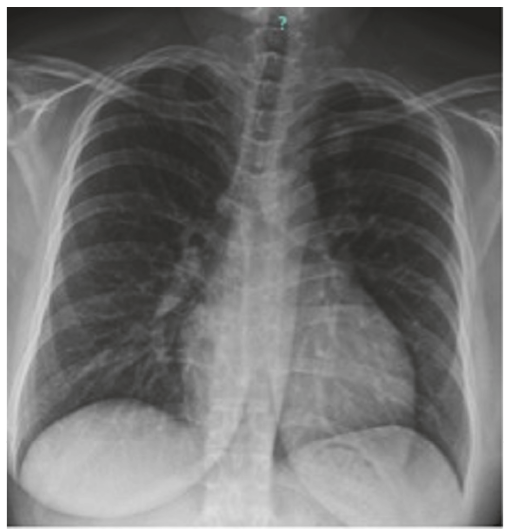
Figure 2: Chest X-Ray showing 2 left upper lobe lung masses.